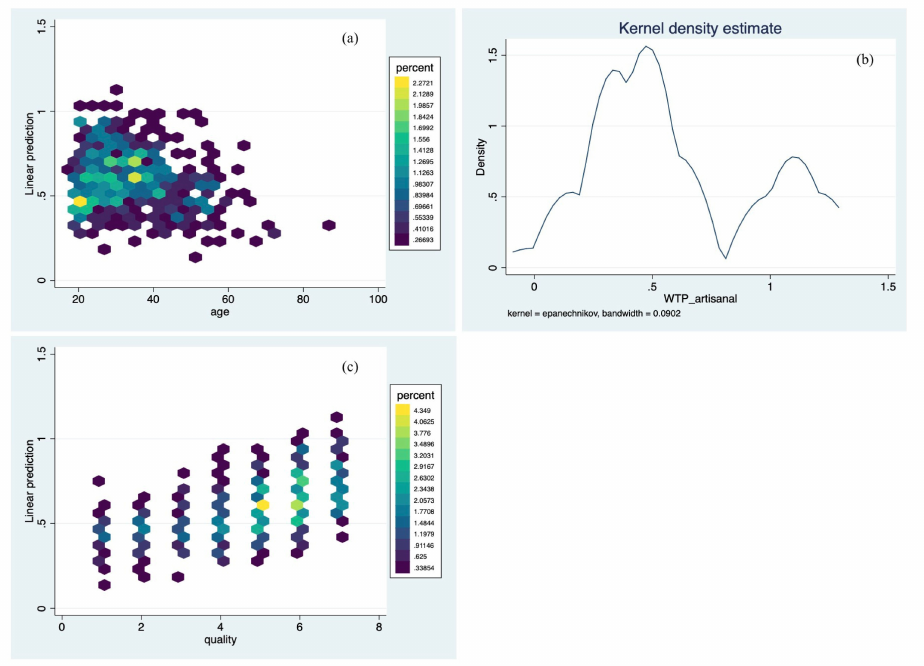
Figure 2. Density of WTP. ( a ) density of the WTP on age; ( b ) Frequency distribution of the WTP for craft beer; ( c ) density of the WTP on